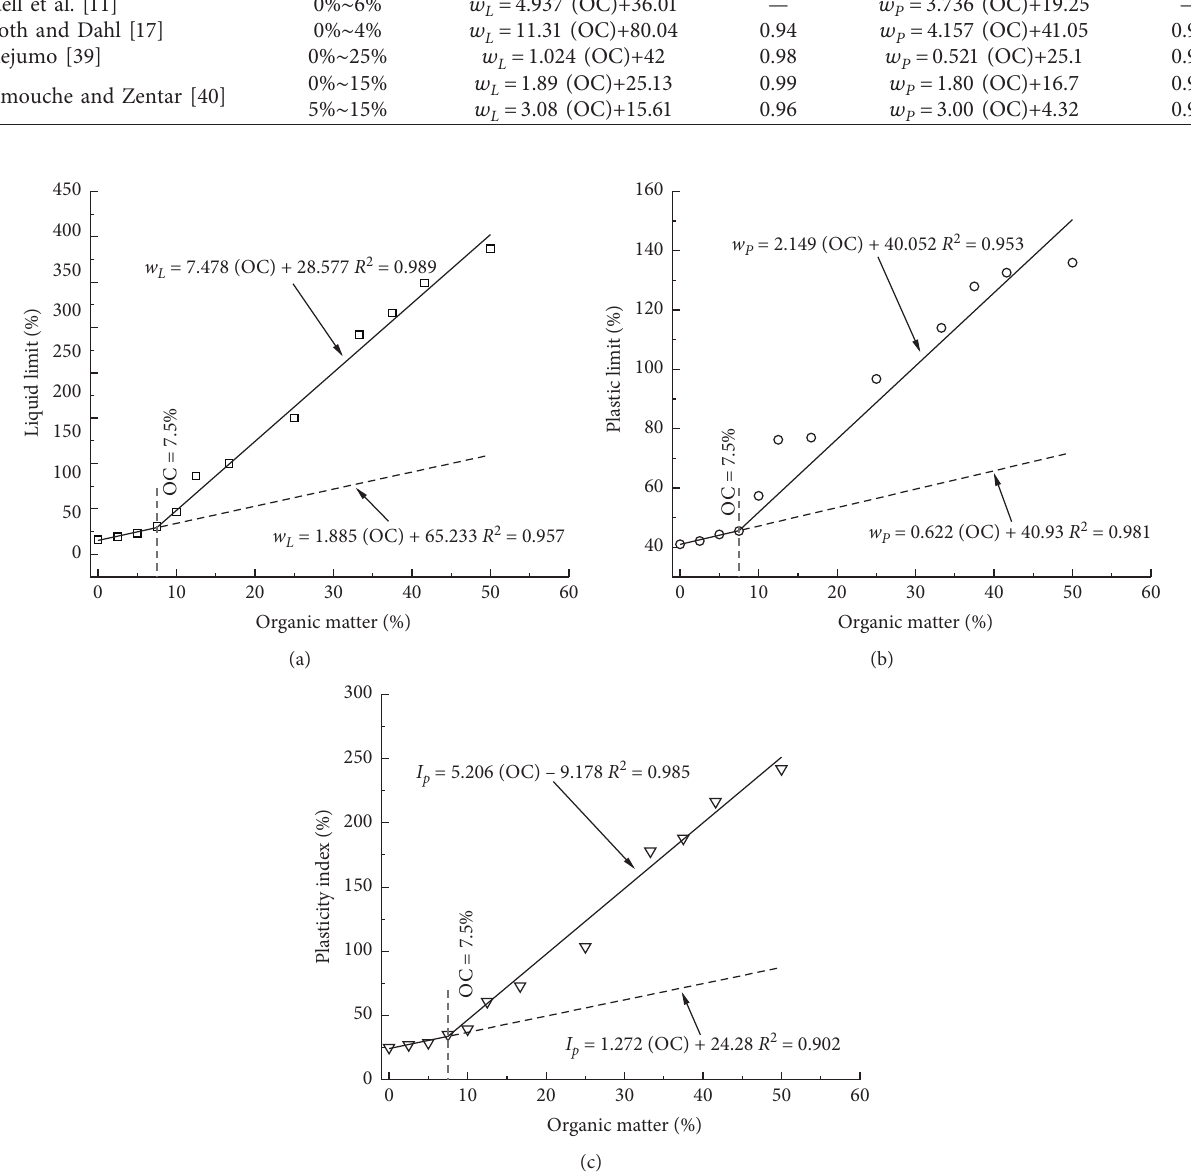
Table 4: Some research results on the relationship between organic matter content and liquid limit ( w Data sources